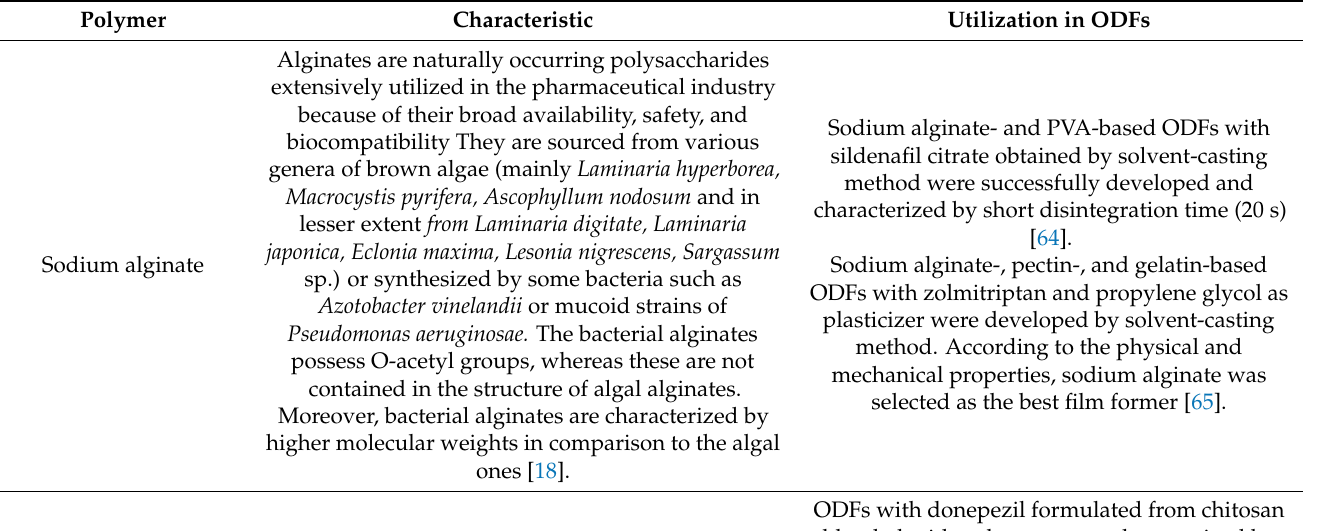
Table 4. Utilization of sodium alginate and chitosan in the ODFs’